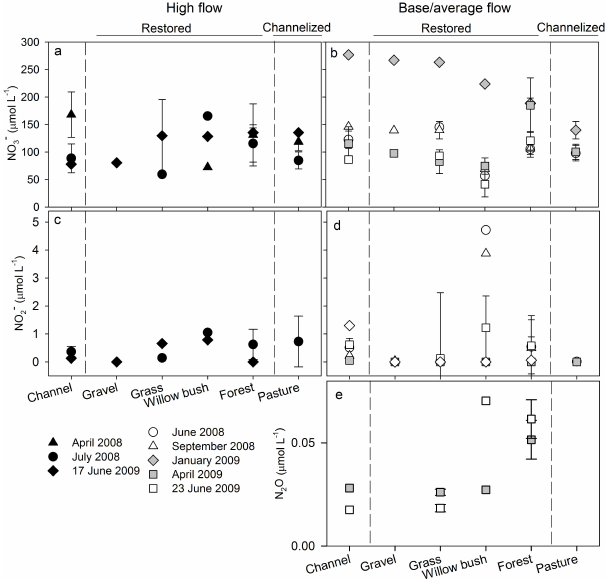
Fig. 3. NO − , NO − and dissolved N 2 O concentrations in different 3 2 riparian zones during high discharge (a, c) and base to average dis- charge of the river Thur (b, d, e) . Values from piezometers located in the same riparian zone were averaged, and error bars represent standard deviations ( n > 2) or average deviations ( n =